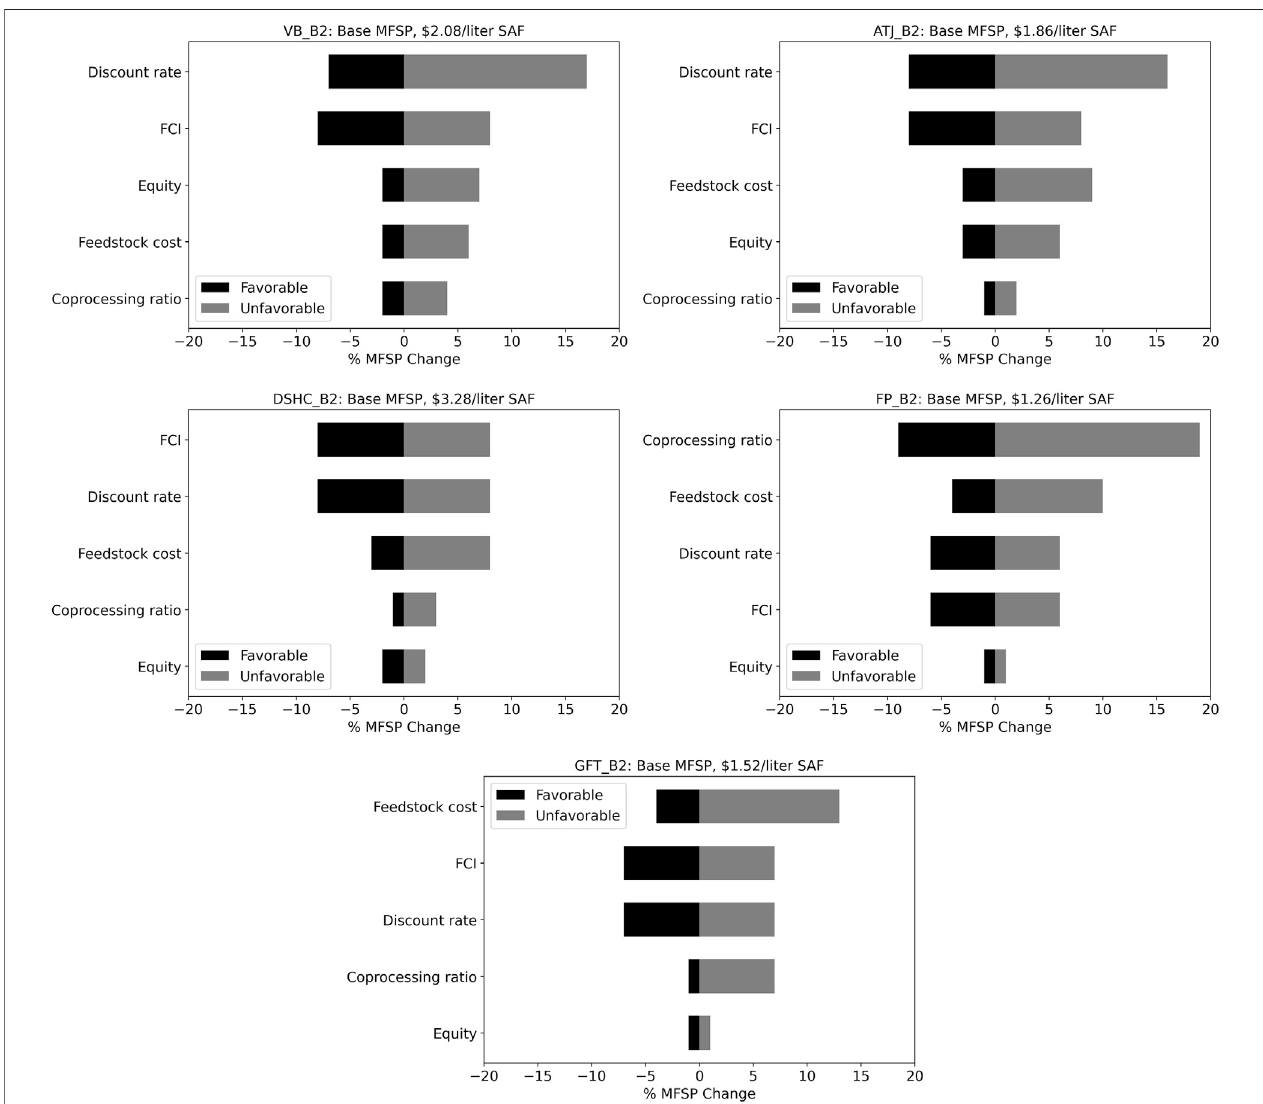
FIGURE 6 | Examples of the sensitivity analyses of integrated scenarios for OSBL sharing.